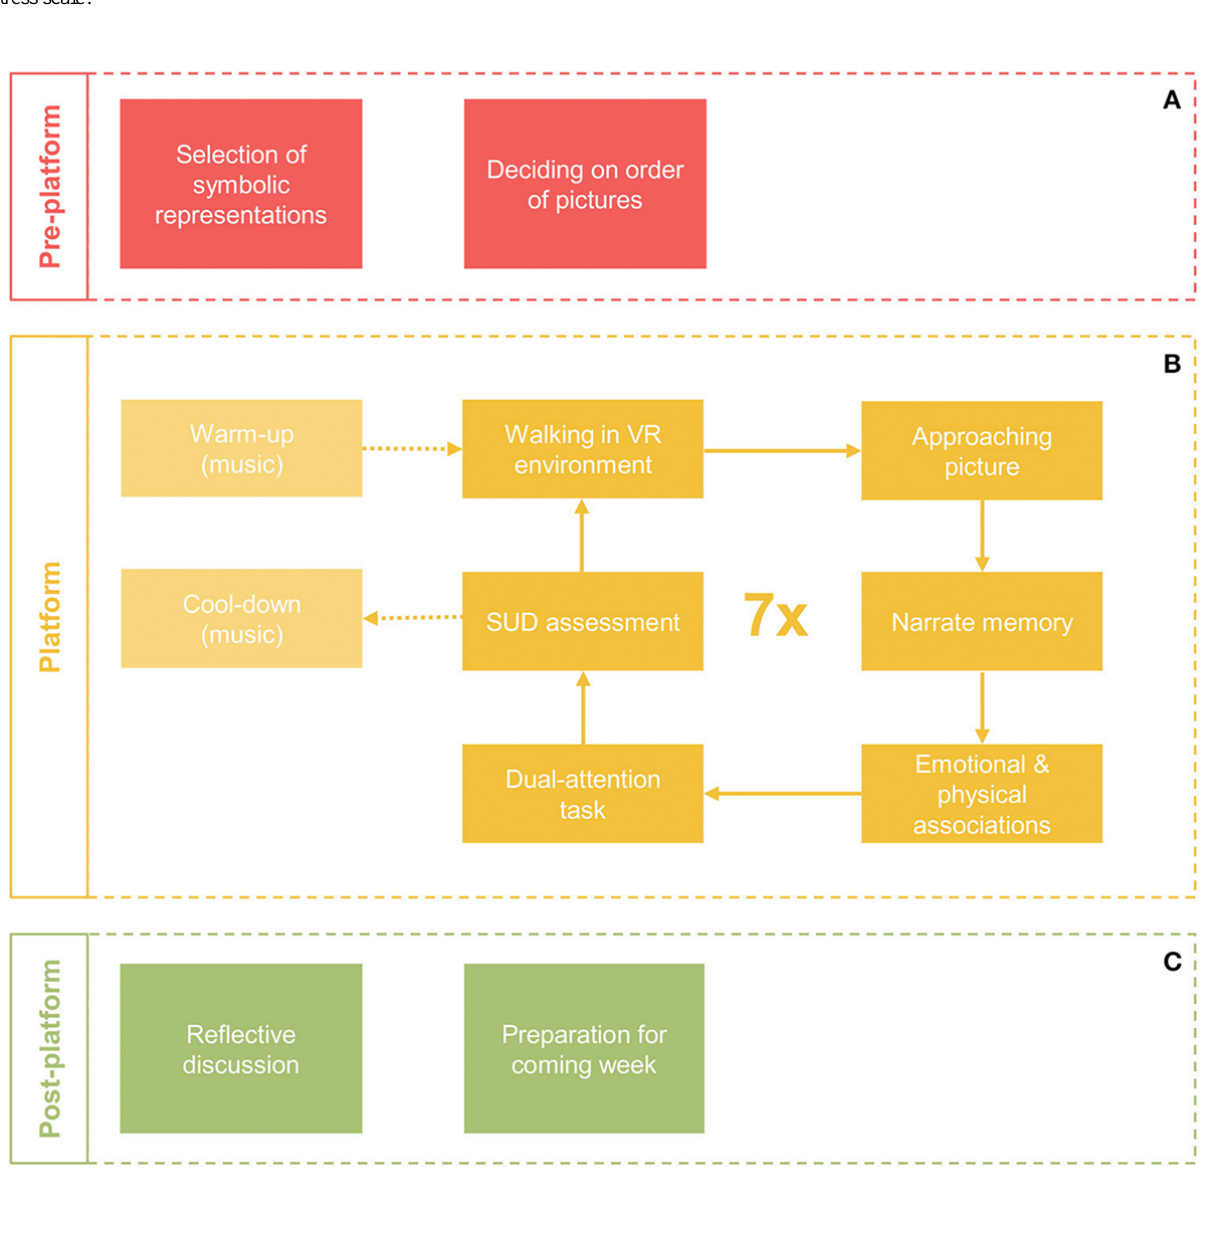
Figure 2. Schematic overview of a single multimodular motion-assisted memory desensitization and reconsolidation (3MDR) session. A session consists of a preplatform phase (A), platform phase (B), and postplatform phase (C). Used with permission [25]. VR: virtual reality; SUD: Subjective Units of Distress